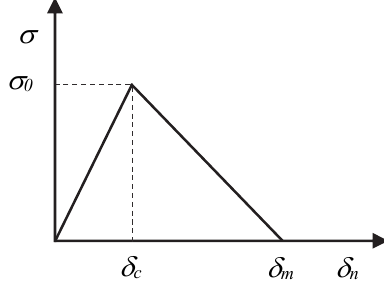
Figure 1: Bilinear traction-separation relationship for mode I loading